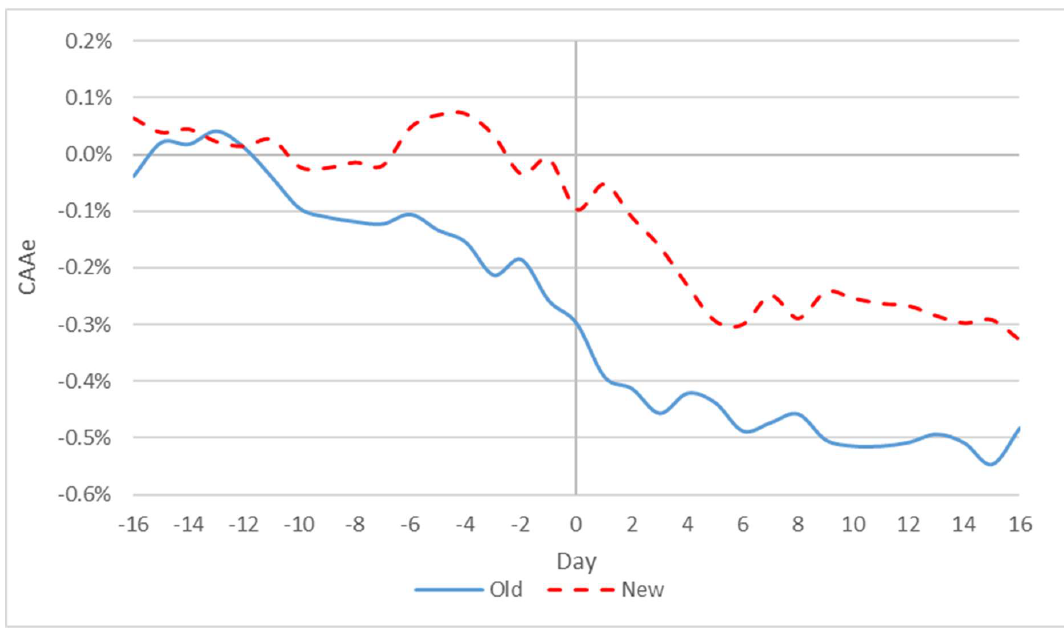
Figure 6. The CAAe behavior during the 33-day event window surrounding the event day for old and new announcements. new announcements. Table 3. The e ff ect of gas discoveries on the exchange rate for old and new